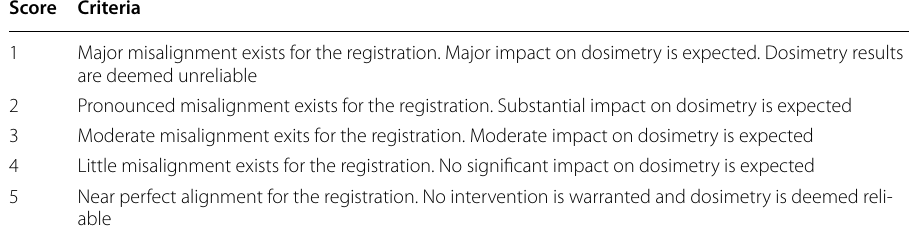
Table 2 Likert score criteria for scoring landmark registration Score